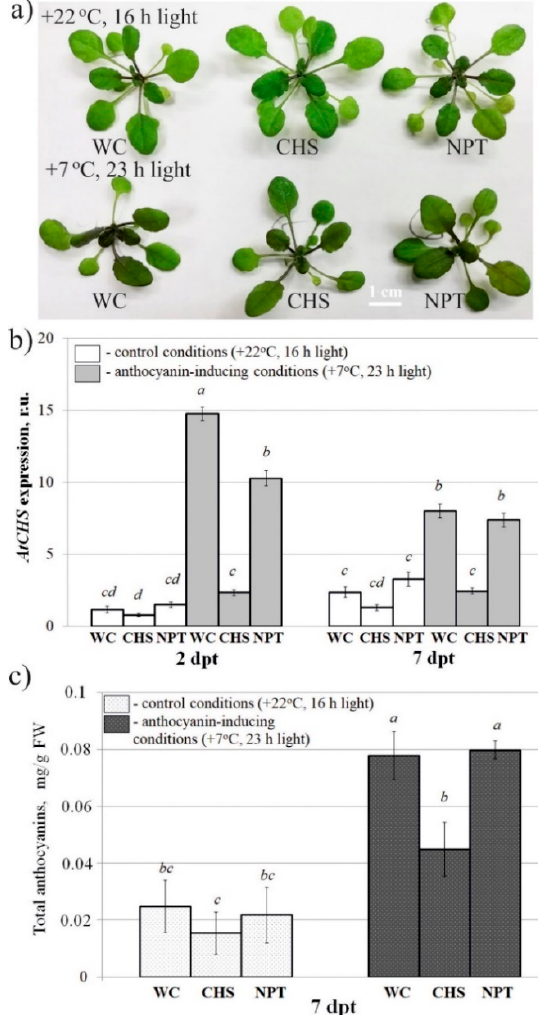
Figure 3. The effect of external AtCHS - and NPTII -encoding dsRNAs on AtCHS mRNA level and total anthocyanin content in Arabidopsis thaliana . ( a ) Arabidopsis plants grown under control (+22 °C, 16 h light, upper panel) and anthocyanin-inducing (+7 °C, 23 h light, lower panel) conditions for seven days after treatment with sterile water or synthetic dsRNA. ( b ) Quantitative real-time PCR measuring relative mRNA levels of endogenous AtCHS in the leaves of A. thaliana treated with water or synthetic dsRNAs. ( c ) HPLC results of total anthocyanins in the leaves of A. thaliana grown under the control and anthocyanin-inducing conditions. WC— A. thaliana treated with sterile water; CHS— A. thaliana treated with AtCHS -dsRNAs; NPT— A. thaliana treated with NPTII -dsRNA; dpt— days post-treatment. The data are presented as the mean ± SE (three independent experiments). Means followed by the same letter were not different using Student’s t test. p < 0.05 was considered statistically